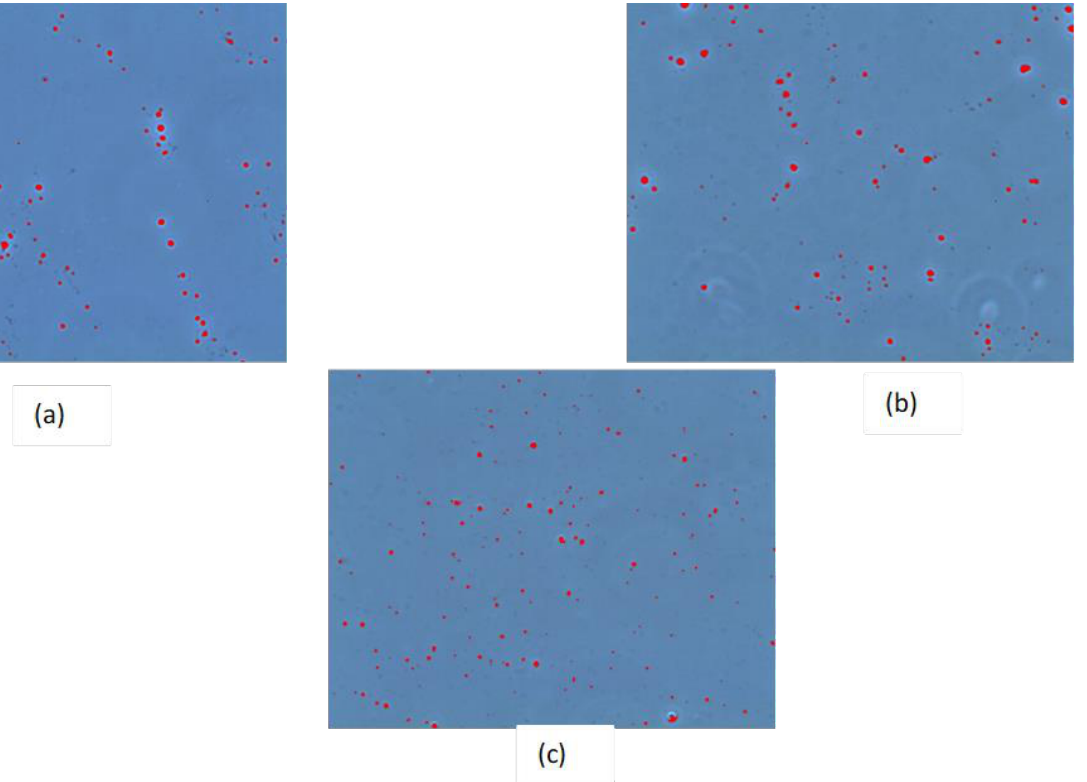
Figure A2. Image examples of emulsions in distillate water ( a ) sample after 1 h, ( b ) sample after 3.5 h, ( c ) sample after experiment at 48 h.